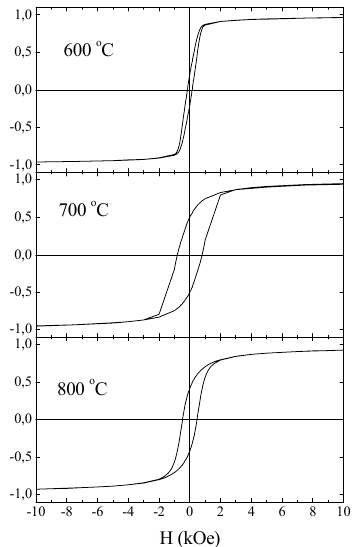
Figure 32. Effect of annealing temperature on hysteresis loop of Co 29 Ni 25 Cu 45 Mn microwire. Reproduced from reference [98], Figure 2.